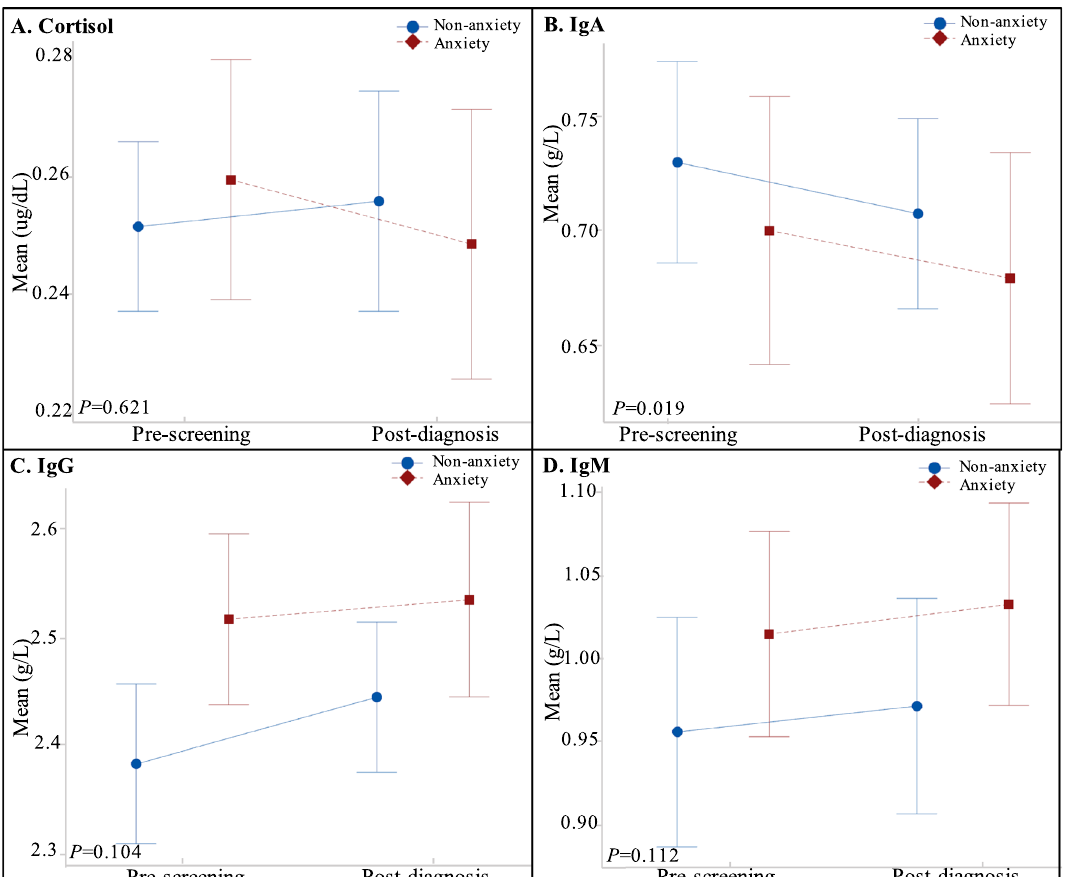
Figure 2. Comparison of cortisol and immunoglobulin levels among participates at pre-screening and post- diagnosis: by anxiety disorders status. ( A ) Mean values of cortisol; ( B ) Mean values of IgA; ( C ) Mean values of IgG; ( D ) Mean values of